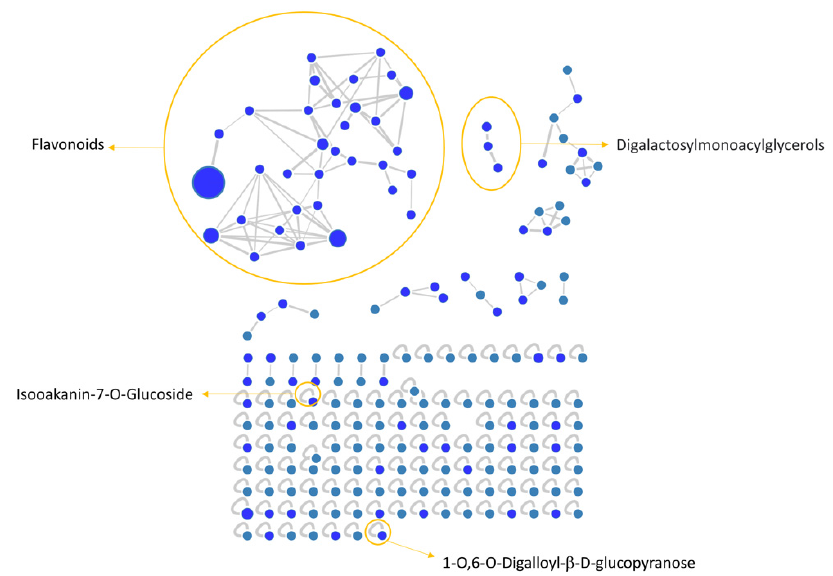
Figure 1. V. vinifera extract Feature Based Molecular Network (FBMN) obtained through GNPS analysis and Citoscape visualization, displaying the presence of flavonoids and digalactosylmonoacylglycerol clusters, together with two unpaired nodes matching with 1-O,6-O-Digalloyl-ß-D-glucopyranose and Isookanin-7-O-glucoside.